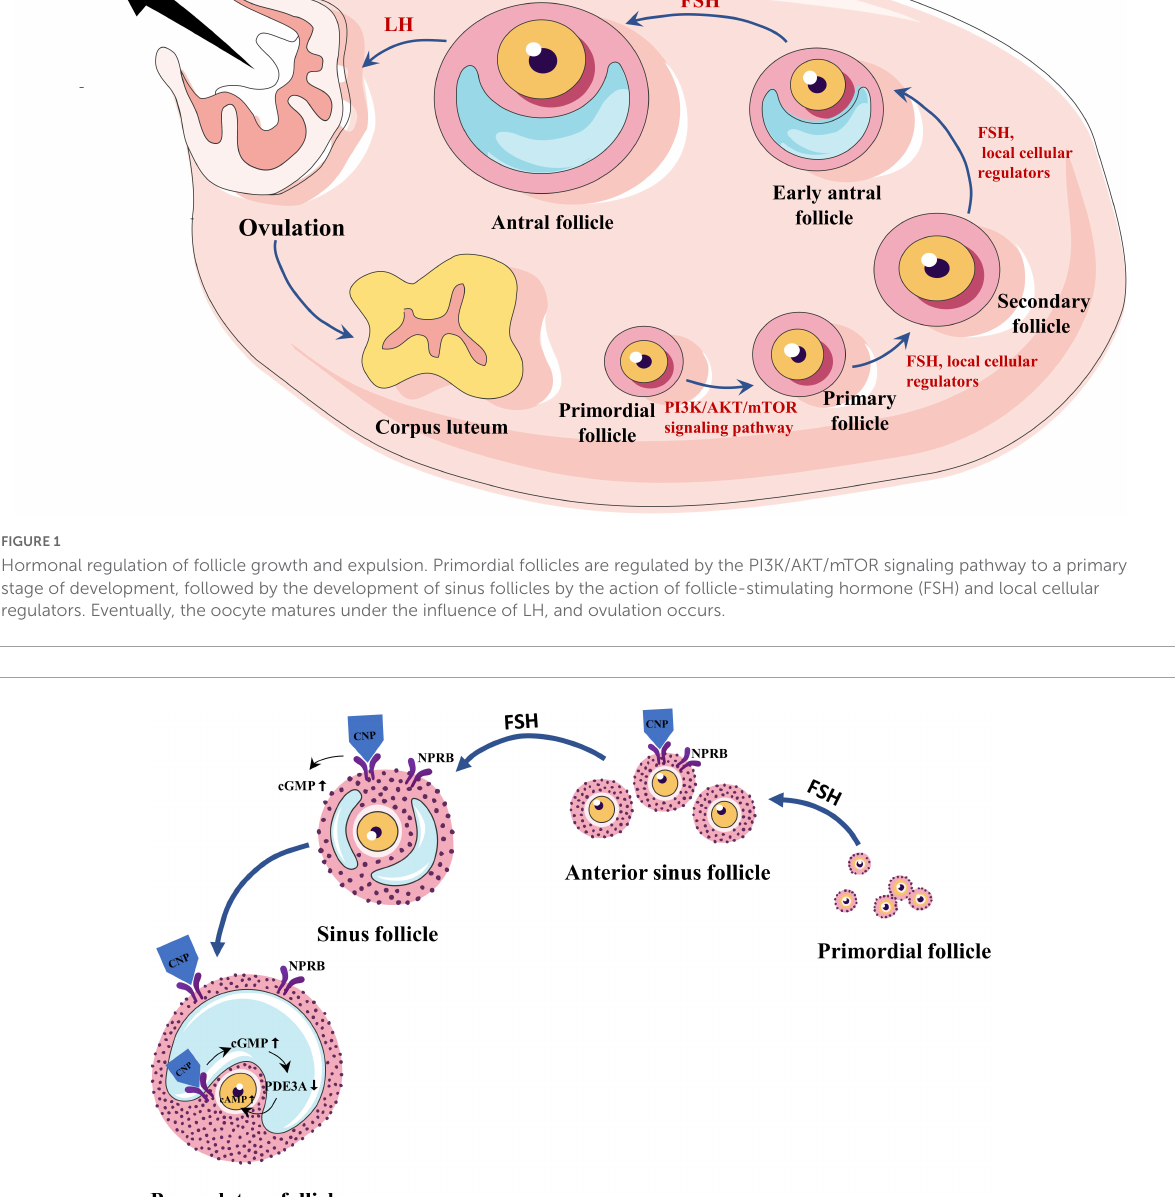
bone morphogenetic protein 15 (BMP15) (12). Studies in mice have revealed that the transcripts of R-spondin2 are only present in primary oocytes and oocytes of larger follicles but not in the initiating follicles (44). The decrease of R-spondin2 level may